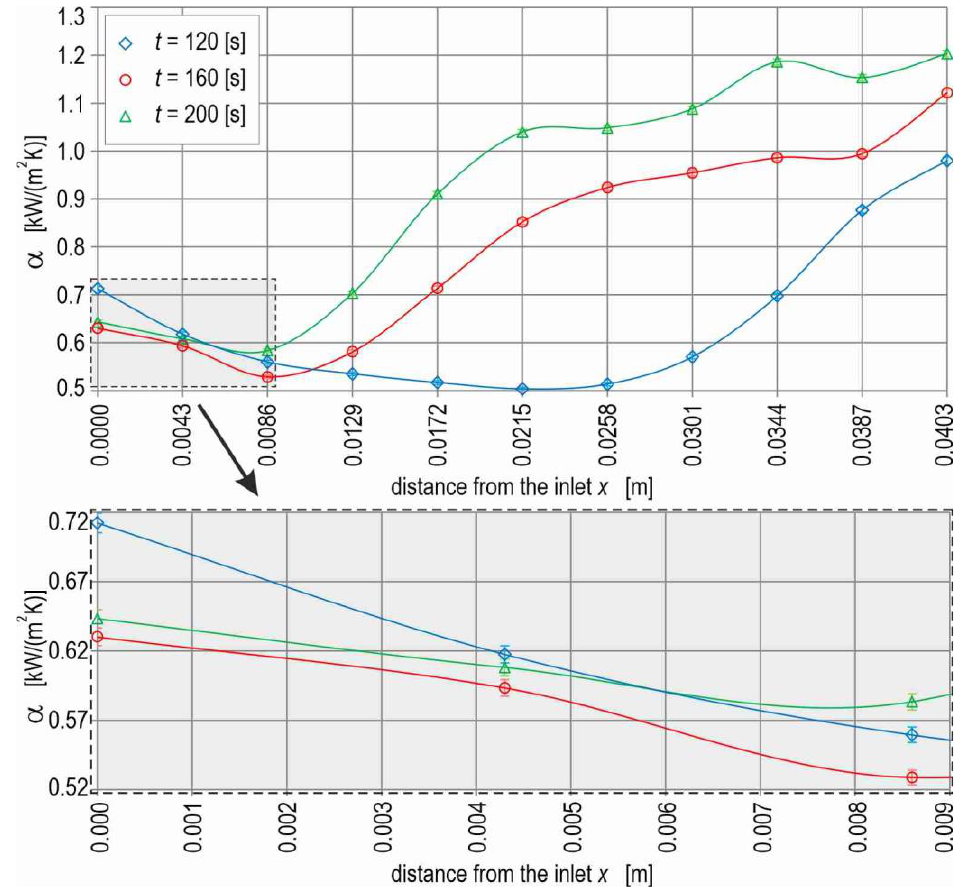
Figure 11. The heat transfer coefficient as a function of distance from the inlet with marked error bars of the heat transfer coefficient, the subcooled boiling region; the results obtained for three selected times and other main experimental parameters shown in Table 1.